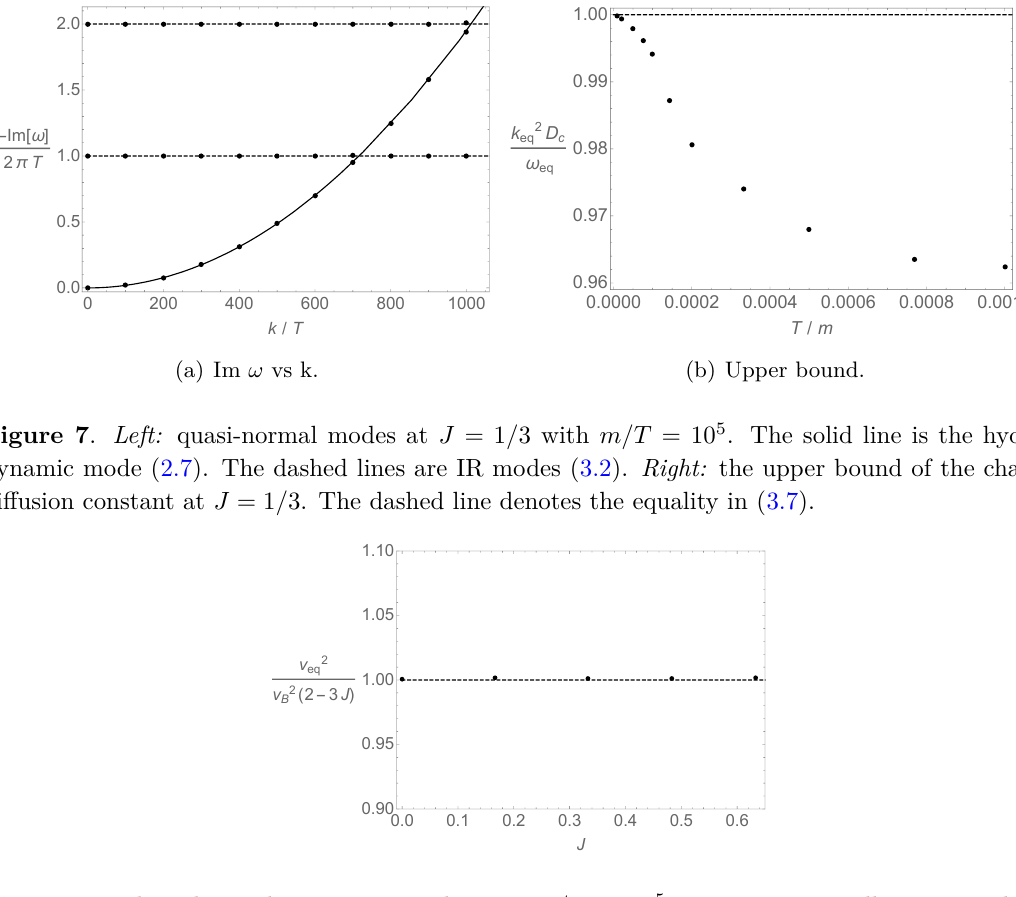
Figure 8 . The relation between v eq and v B at m/T = 10 5 . v eq is numerically computed via ω eq /k eq (4.8), while v B is from (4.3). Dots are numerical data at J ∈ [0 , 2 / 3) and the dashed line is